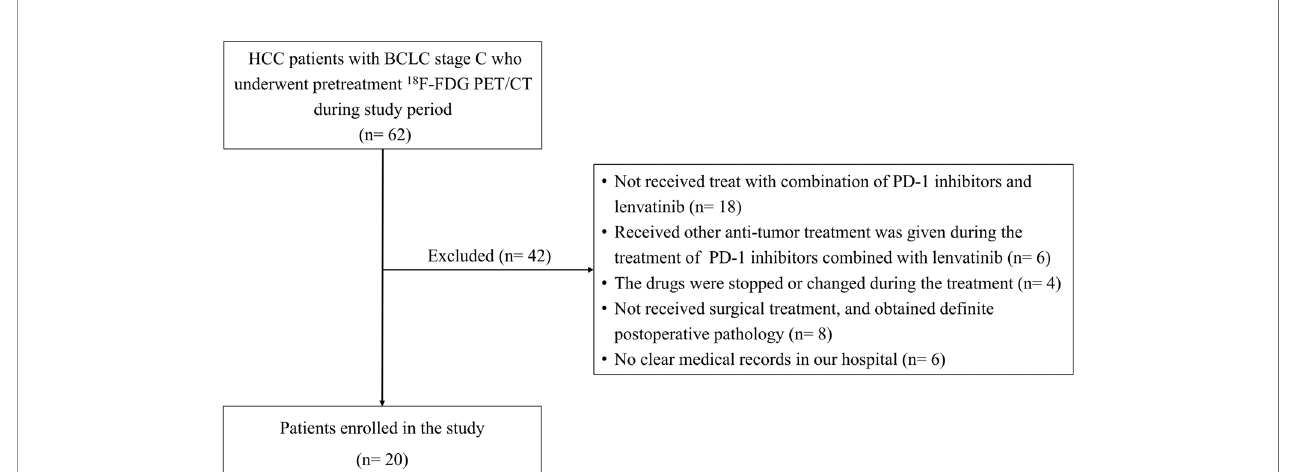
FIGURE 1 | Patient in- and exclusion fl ow diagram. HCC, Hepatocellular carcinoma; BCLC, Barcelona Clinic Liver Cancer; 18 F-FDG PET/CT, 18 F- fl uorodeoxyglucose positron emission tomography/computed